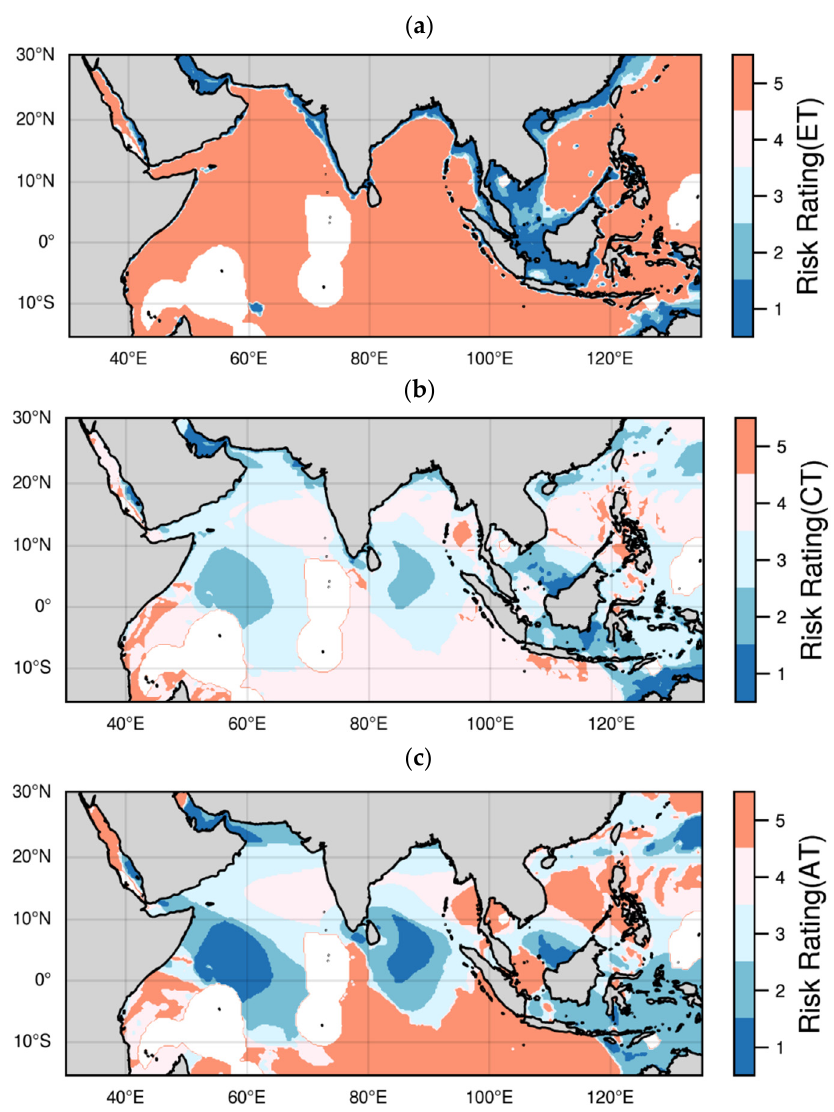
Figure 4. Comparison of weight results: ( a ) entropy weight; ( b ) CRITIC weight; ( c ) analytic hierarchy process weight (the blanks are missing parts of ICRG data).